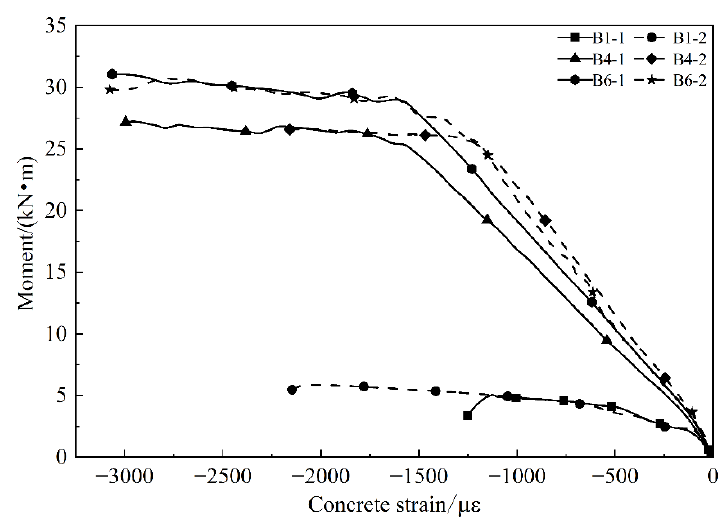
Figure 7. Moment–concrete-strain curve for the RASCC and NC beams.